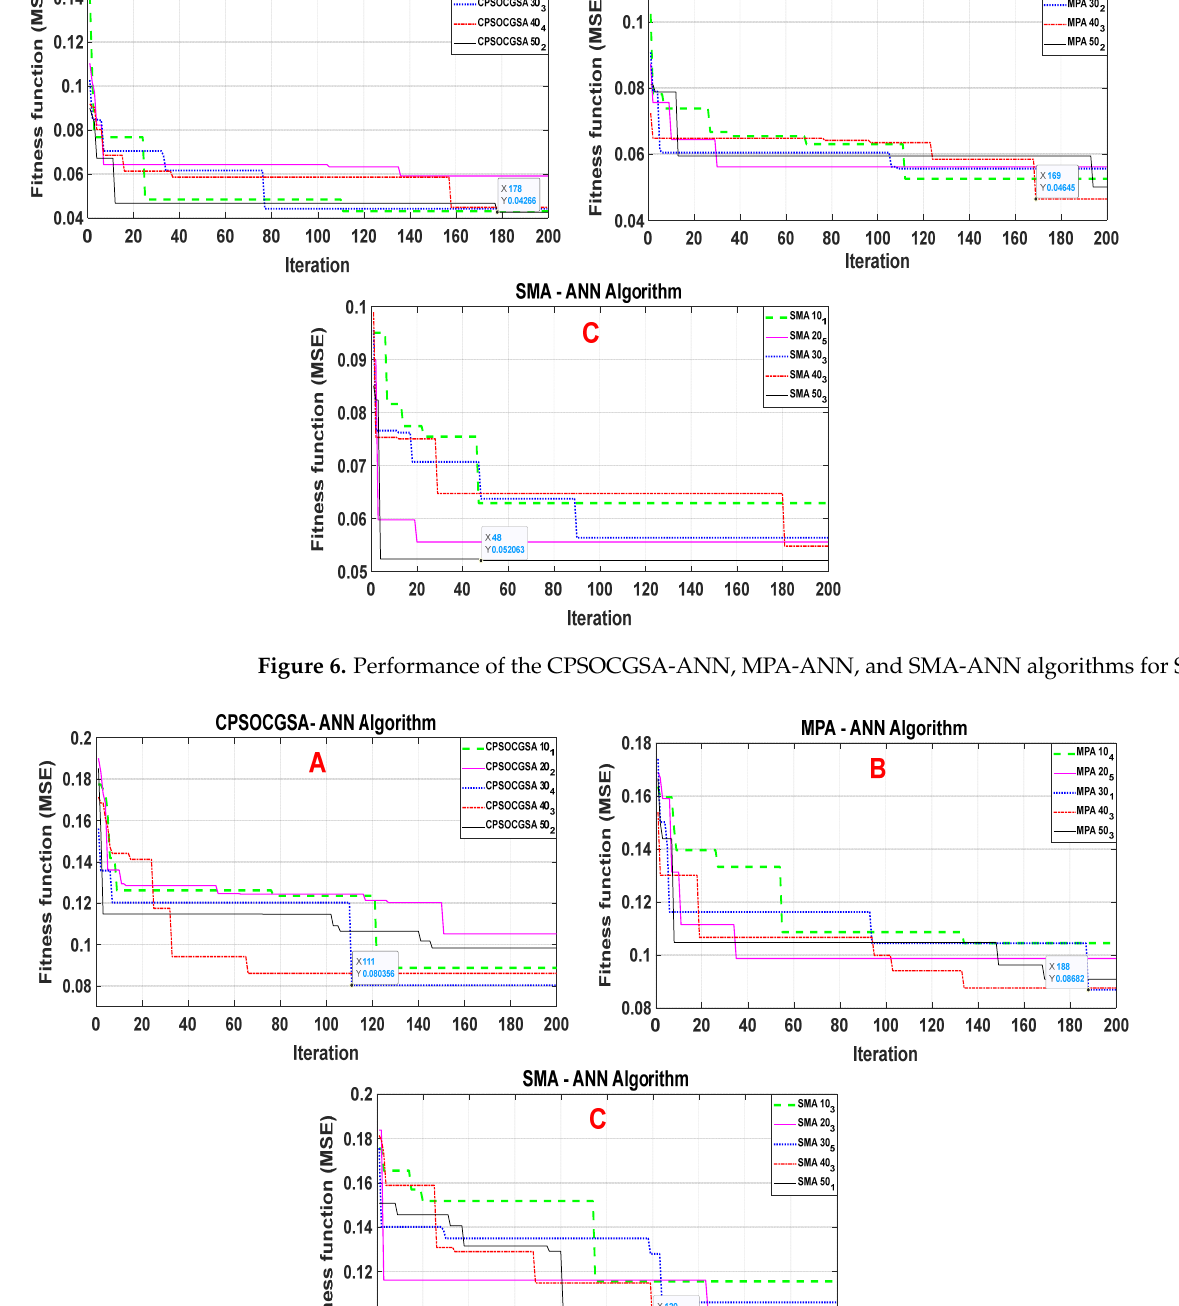
Figure 7. Performance of the CPSOCGSA-ANN, MPA-ANN, and SMA-ANN algorithms for SPI 3.